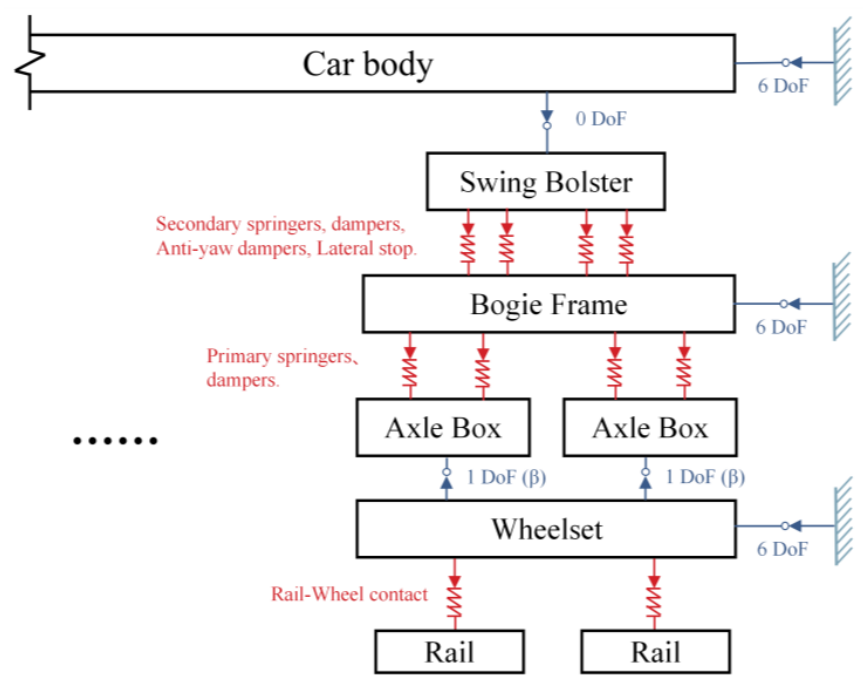
Figure 2. The topological graph of the vehicle model.